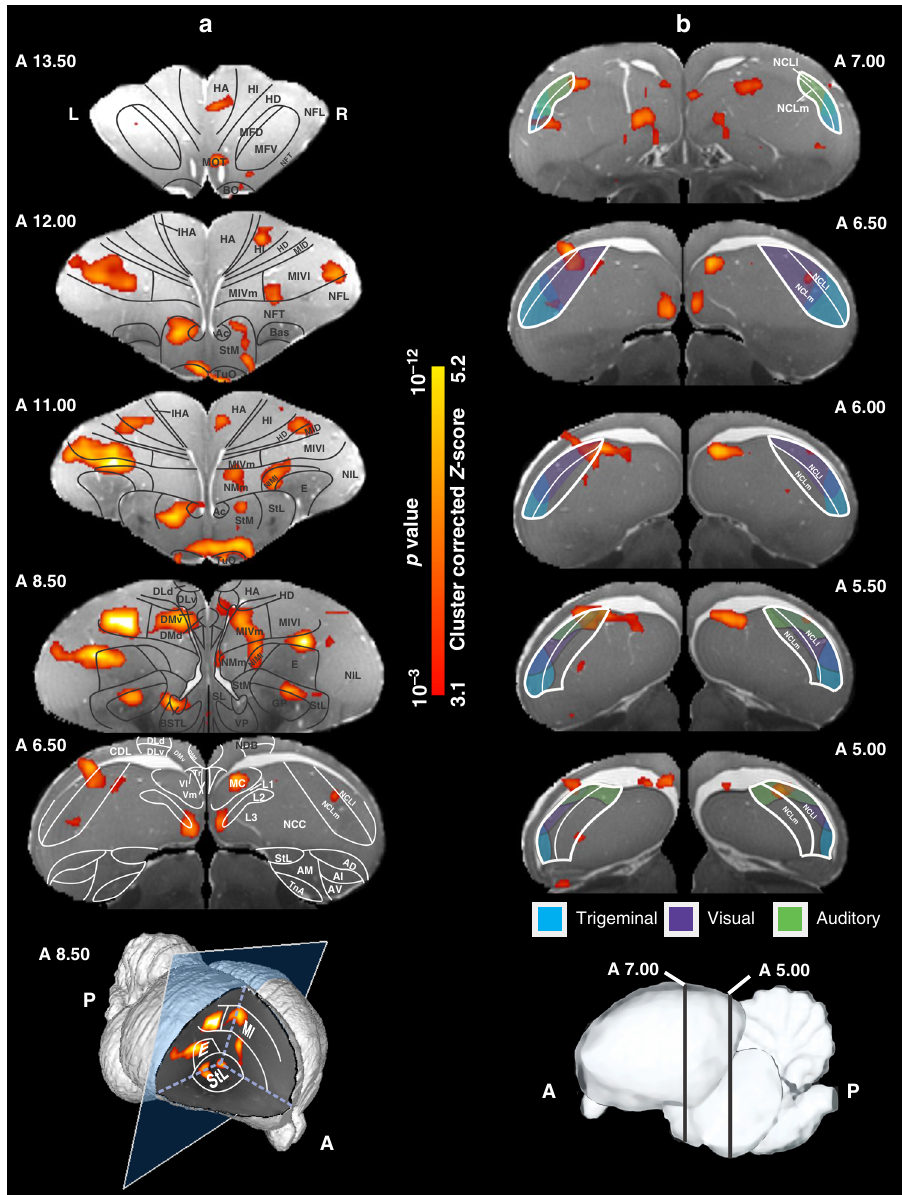
Fig. 3 BOLD response pattern during the color discrimination task. Coronal images at different levels of the pigeon telencephalon with overlay of anatomical borders based on the pigeon MRI atlas 73 . Pigeon atlas images are shown in gray scale, while the areas activated signi fi cantly during the color discrimination task (contrast of Go > NoGo + mandibulation) are highlighted in color ( Z = 3.1 and p < 0.05 FWE corrected at the cluster level, group analysis). Results demonstrate activated clusters in a visual, olfactory, auditory, trigeminal, tactile, and polysensory areas; limbic and basal ganglia components; and b memory- and executive control-related pallial areas (see also Fig. 5 and Supplementary Fig. 6). The last image on the left column shows a 3D representation of the pigeon brain with an example window at level A 8.50. Anatomical borders in b are based on study by Herold et al. 50 and color- coded areas (red, green, and yellow) represent the terminal fi elds of afferents from secondary sensory areas on the NCL, based on Kröner and Güntürkün 77 . The last image of the right column shows a 3D representation of the selected coronal images from NCL. HI high intensity, LH low intensity. The corresponding abbreviations of ROIs are listed in the Supplementary Table